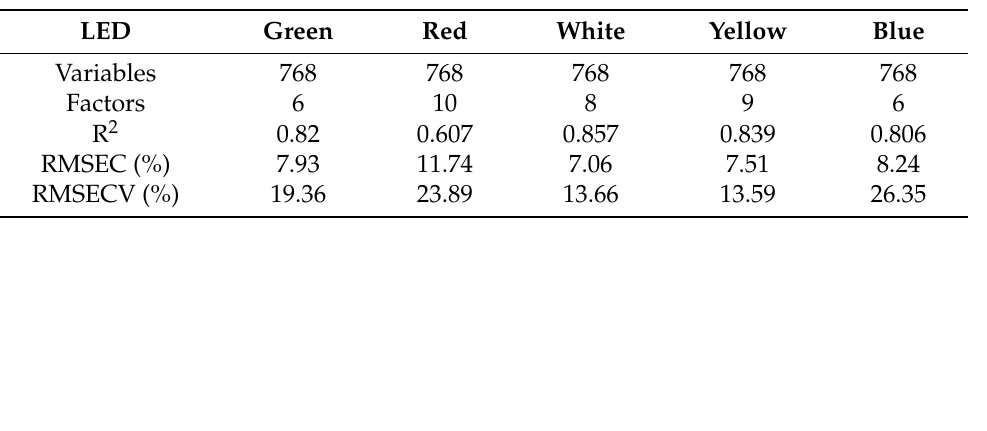
Table 3. Results obtained comparing all training models by